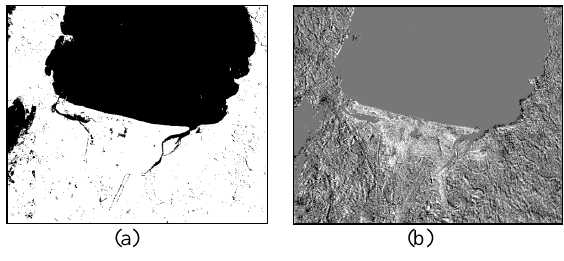
Figure 9. The water mask processing: (a) Water mask and (b) Image result after the water mask